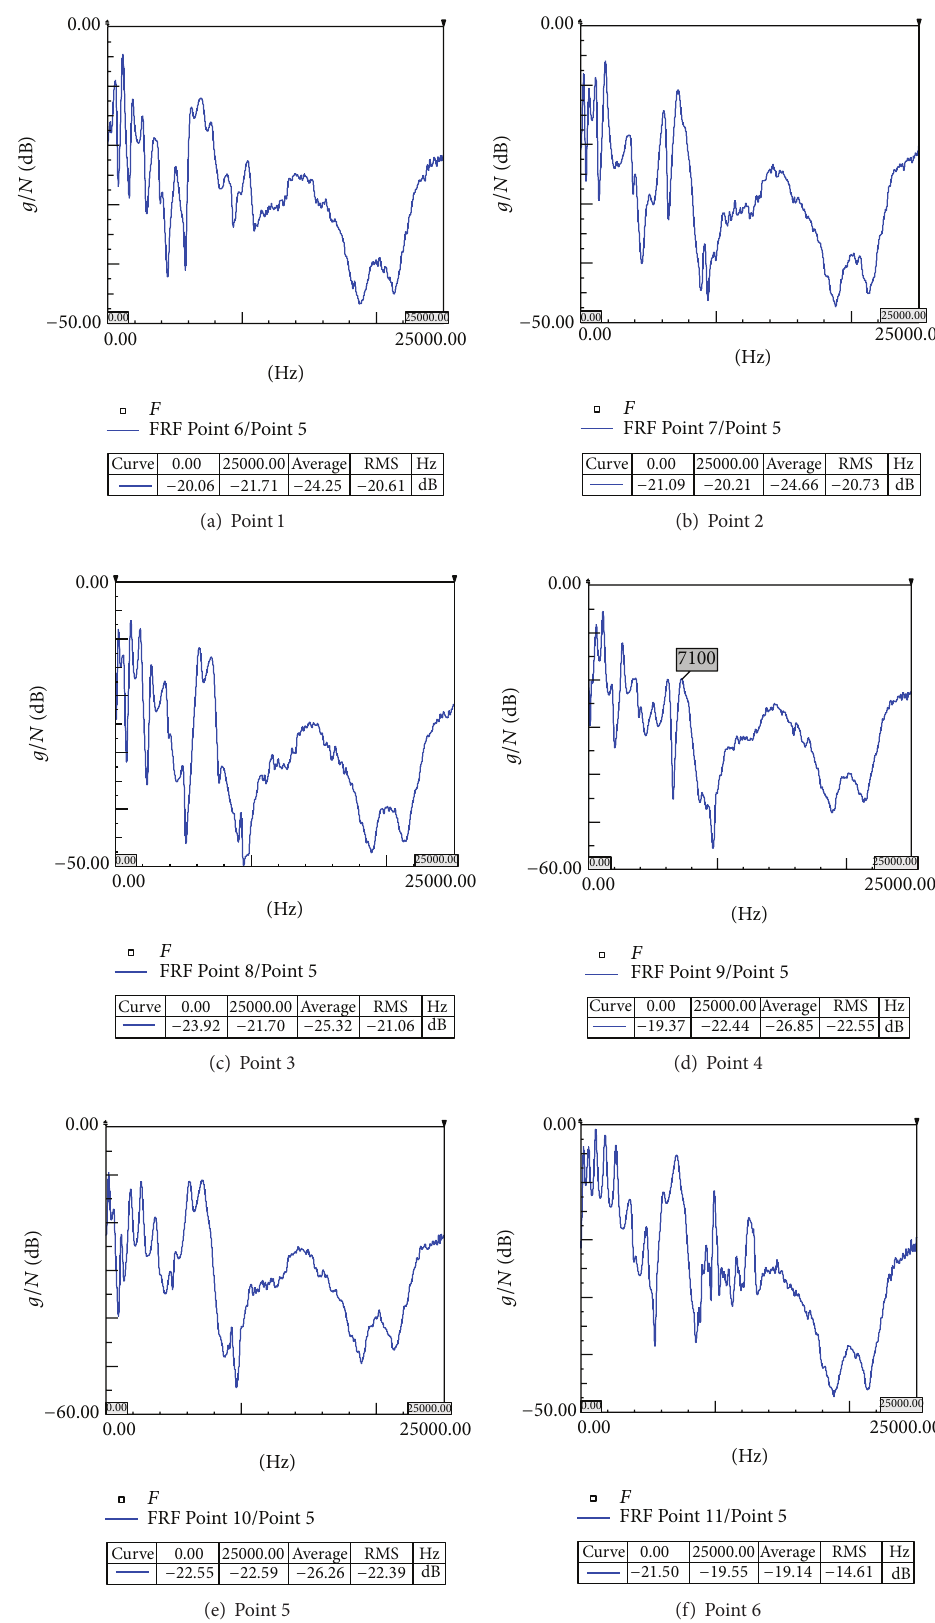
Figure 4: Transmission characteristic curve of phononic crystals at the output